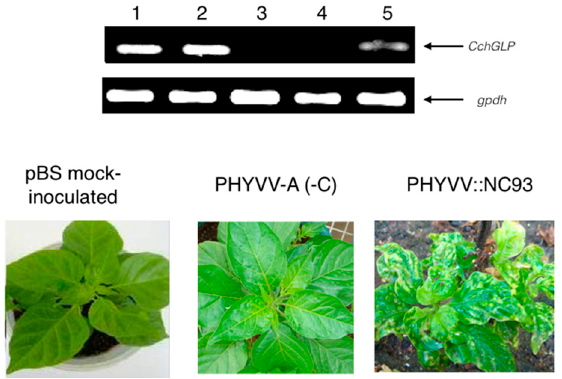
Figure 3. Molecular and phenotypical analysis in C. chinense BG ‐ 3821 using PHYVV::NC93 construction. Lane 1 , pBS mock ‐ inoculation; lane 2 , PHYVV ‐ A ( ‐ C); lane 3 , PHYVV::NC93 silenced plant; lane 4 , − control; lane 5 , + control. Panel B, lanes 1–5 corresponds to the same treatments as in panel A. In the bottom section symptomatology is displayed at 30 days post ‐ inoculation of mixed infection by both PHYVV and PepGMV wt components A and B. Negative control corresponds to plants pBS mock ‐ inoculated. Positive control samples came from plants sprayed with salycilic acid 0.01 mM, which is a potent CchGLP inductor as reported by [14]. A housekeeping gene (gpdh, encoding glyceraldehyde phosphate dehydrogenase) was used as constitutive control.